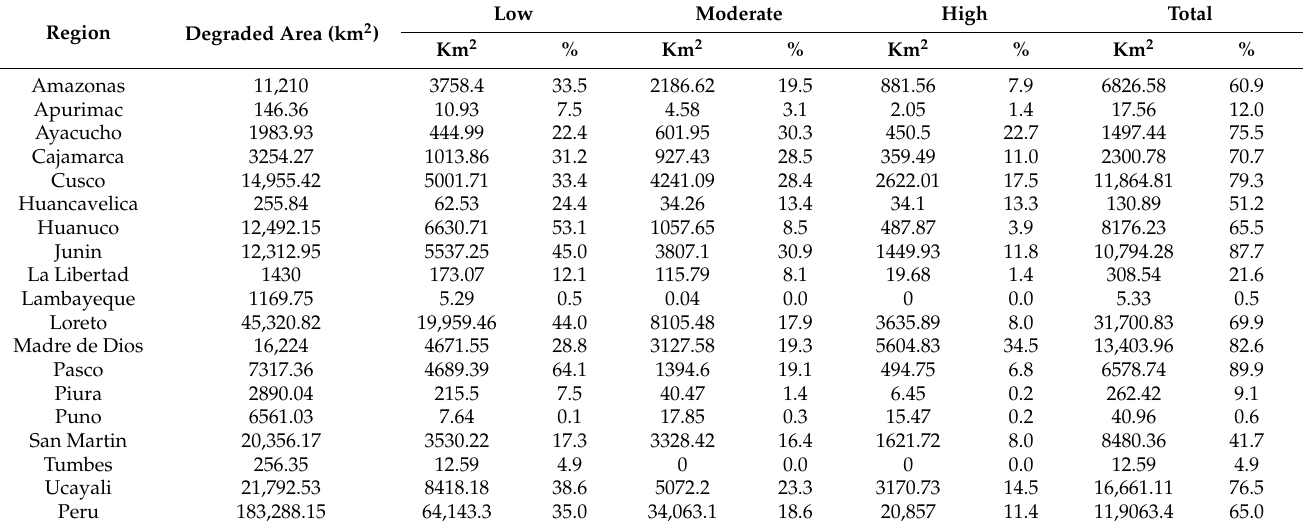
Table 6. Departments with potential area of recovery of degraded areas with Cedrela in Peru.